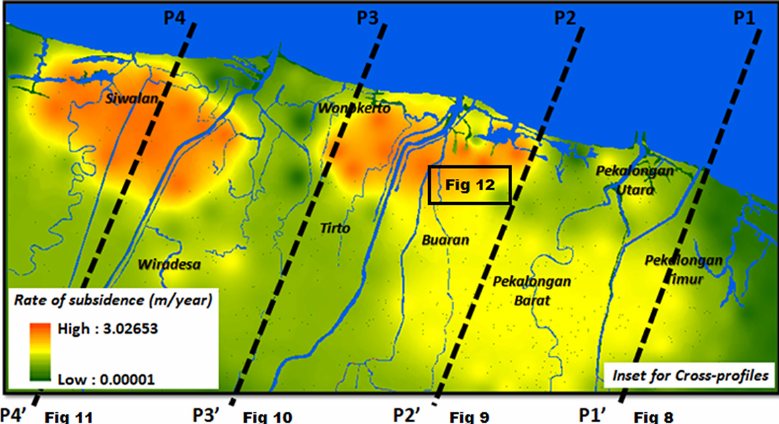
Fig. 3. The rate of subsidence (3 cm yr −1 on average) was obtained based on research by Nashrrullah et al. (2013). Inset are locations for Fig. 8, 9, 10, 11, and